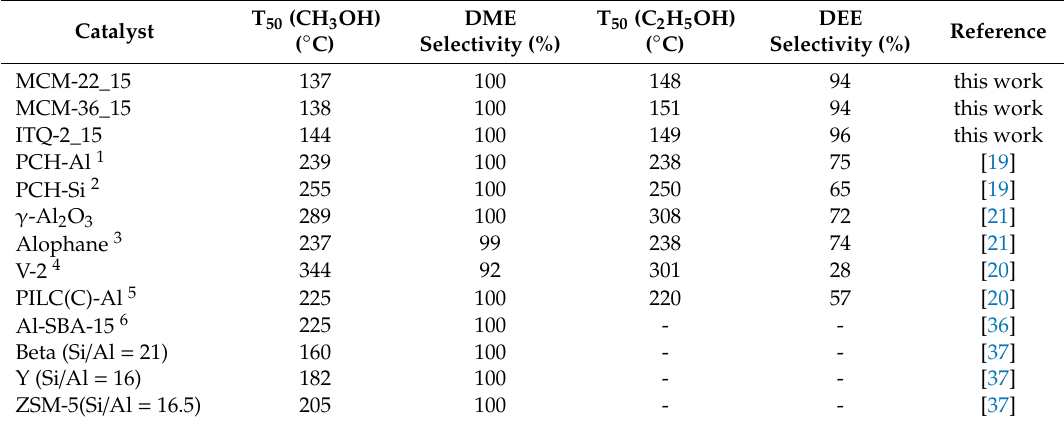
Table 4. Comparison of various catalysts in methanol and ethanol